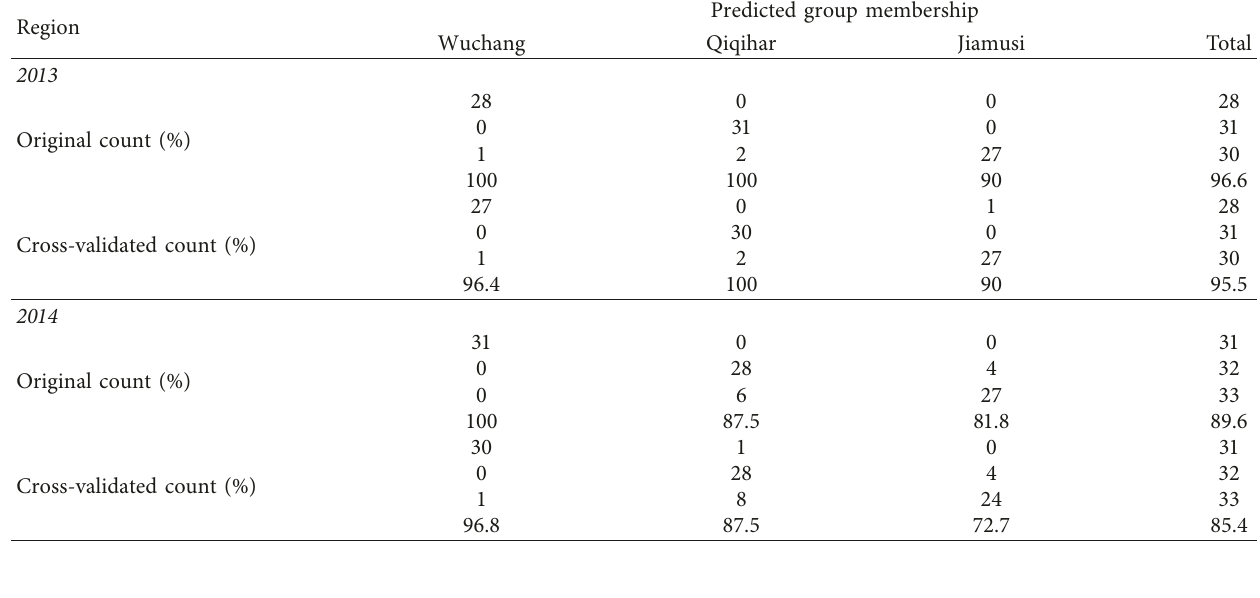
Table 7: Linear discriminant analysis of elements in rice from three regions.